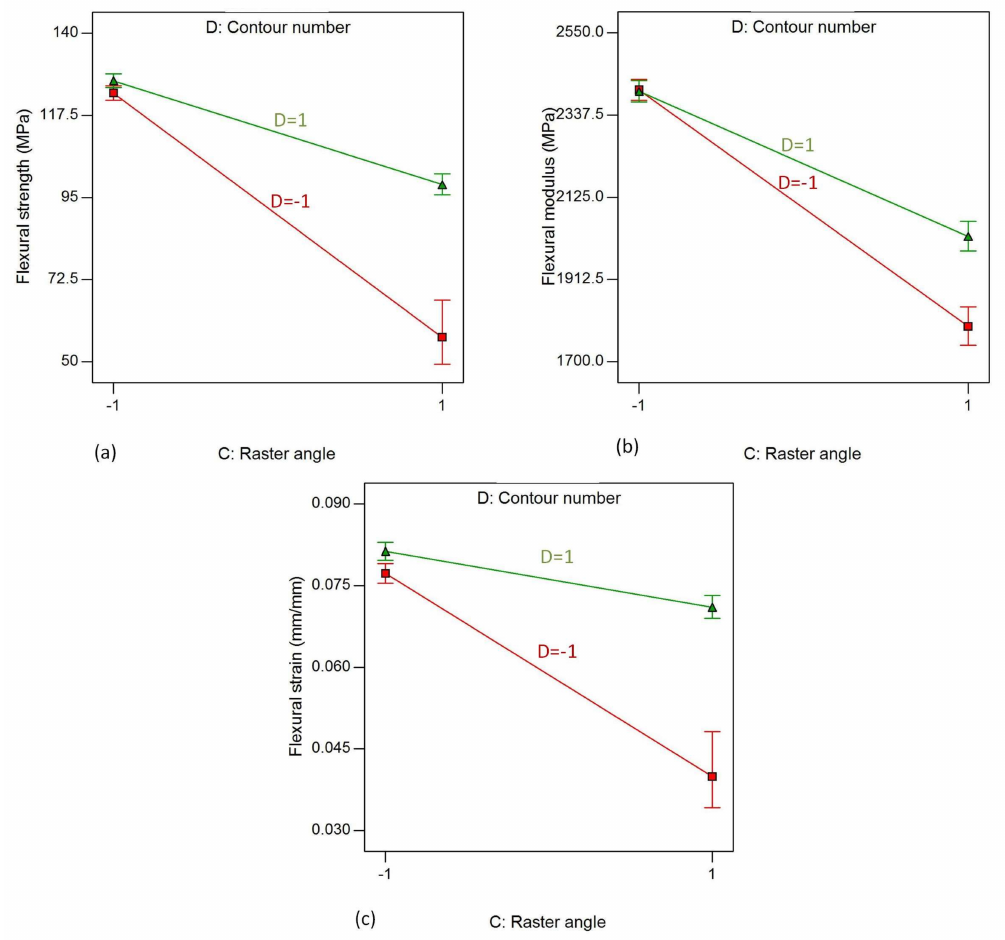
Figure 17. Interaction effect of raster angle and contour number on ( a ) flexural strength; ( b ) flexural modulus, and ( c ) flexural strain, while air gap, rsater width and contour width are kept at their highest